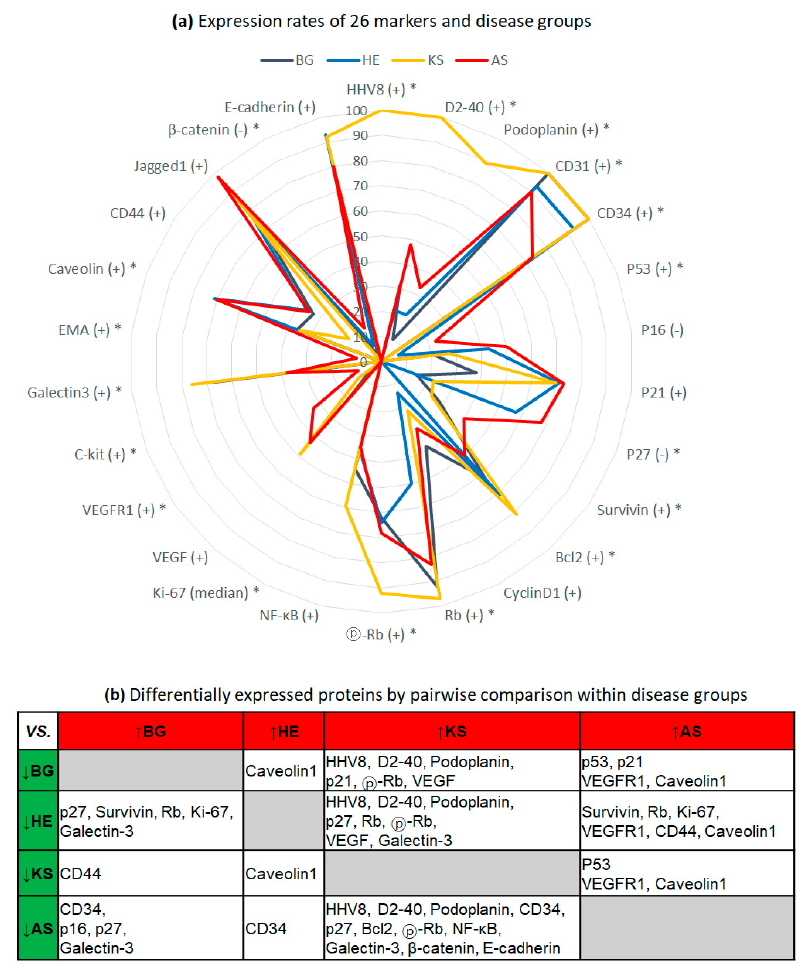
Figure 1. Expression rates of 26 markers according to disease groups. ( a ) Radar chart of expression rates, where the radius is the percentage expression. * p < 0.05. ( b ) Differentially expressed proteins obtained by pairwise comparisons between disease groups. Markers that showed significant differences in expression between two groups (chi-square test or Fisher’s exact test p < 0.05) are listed in intersecting cells, markers with high expression rates are listed along columns, and markers with low expression rates are listed along rows.